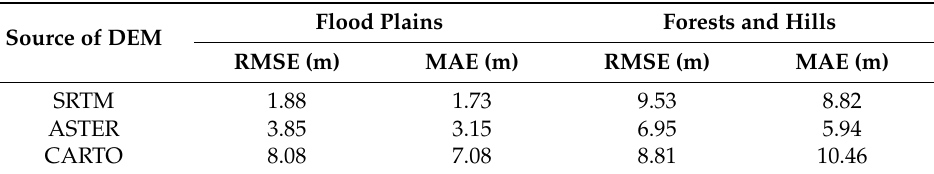
Table 2. Comparison of elevations in the three DEMs (i.e., Advanced Spaceborne Thermal Emission and Reflection Radiometer (ASTER), Shuttle Radar Topography Mission (SRTM), and Cartosat-1 (CARTO)) and the Differential Global Positioning System (DGPS).